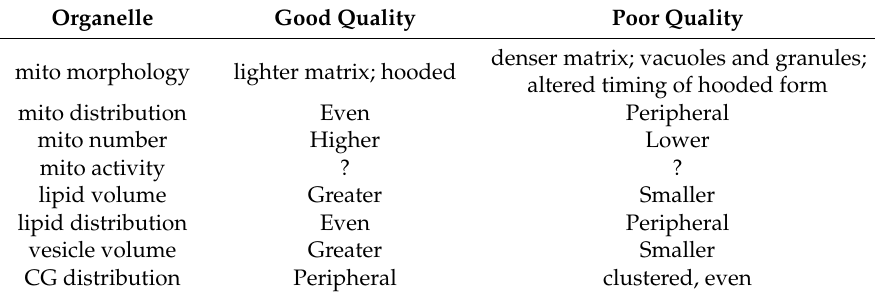
Table 1. Summary of organelle features in good and poor quality mature